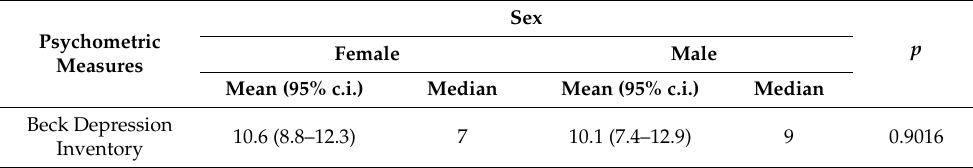
Table 2. Sex and measures of depression